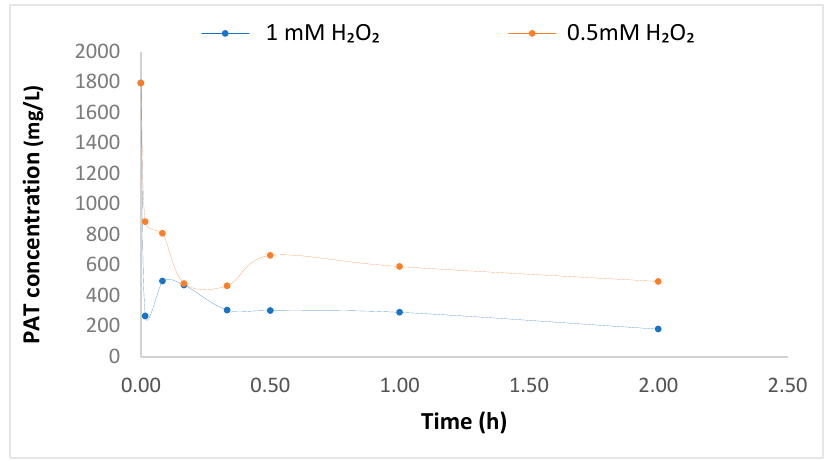
Figure 5. Graph illustrating degradation of PAT in apple juice sample for systems at different H 2 O 2 concentrations .